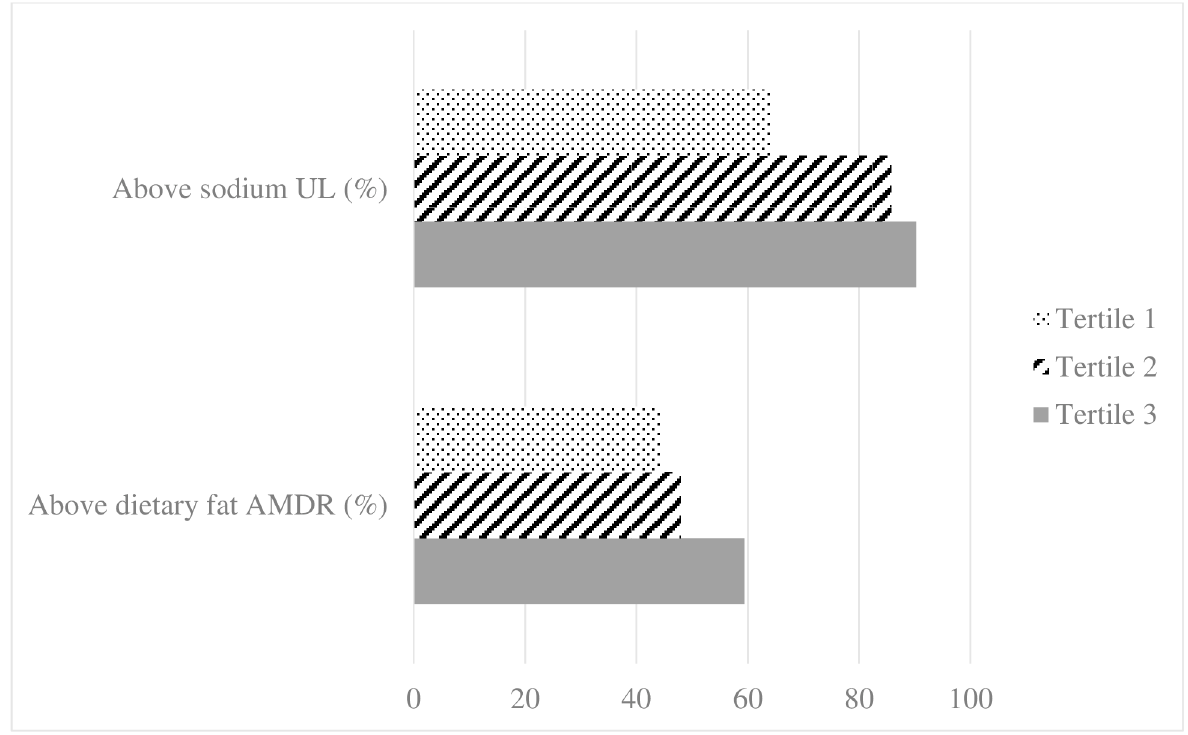
Fig 1. The percentages of individuals with above recommended levels of dietary fat and sodium across tertiles a . a Daily dietary fat beyond the Acceptable Maconutrient Distribution Range(AMDR)(20% – 35%) in tertile 1, tertile 2 and tertile 3, P = 0.054; daily sodium intake beyond the Tolerable Upper Intake Levels (2300 mg/fay) in tertile 1, tertilr 2 and tertile 3, P <